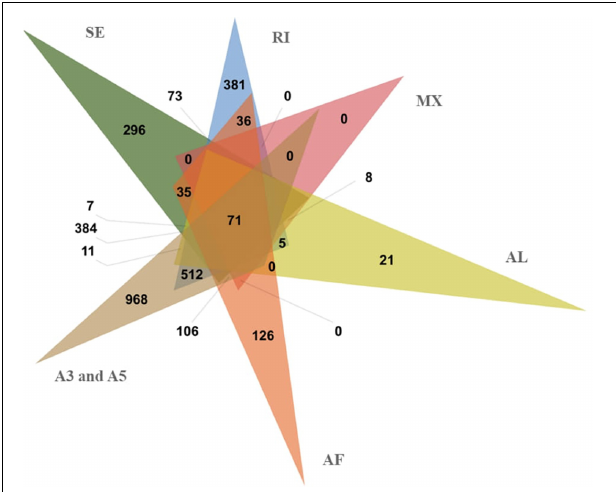
FIGURE 5 | Alternative splice event distribution of abdominal and subcutaneous adipose.